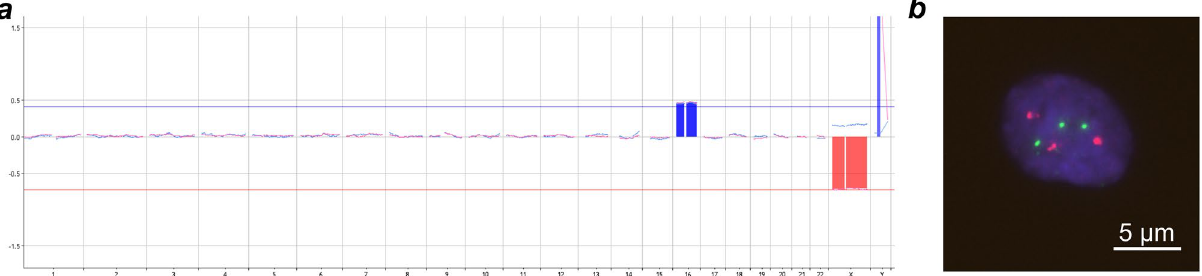
Figure 1. Results of cytogenetic analysis of chorionic villous trophoblasts of miscarriages with trisomy 16. ( a ) Example of the aCGH profile in chorionic villous trophoblasts with trisomy 16. (b) Example of chorionic villous trophoblasts with trisomy 16 based on the results of FISH analysis with two-color subtelomeric DNA probes specific to 16p (red) and 16q (green). Interphase nuclei were stained with DAPI